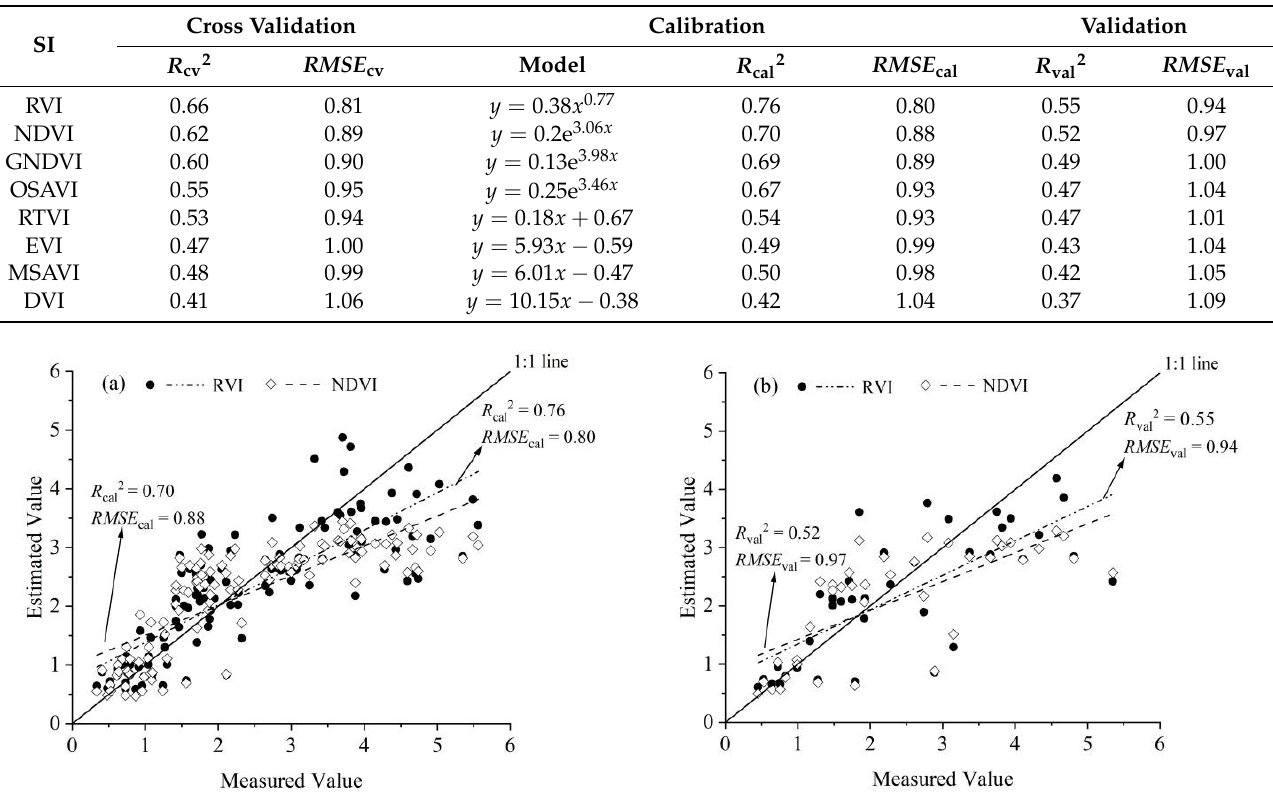
Figure 4. Results for LAI prediction model of RVI and NDVI. ( a ) Calibration; ( b ) Validation.